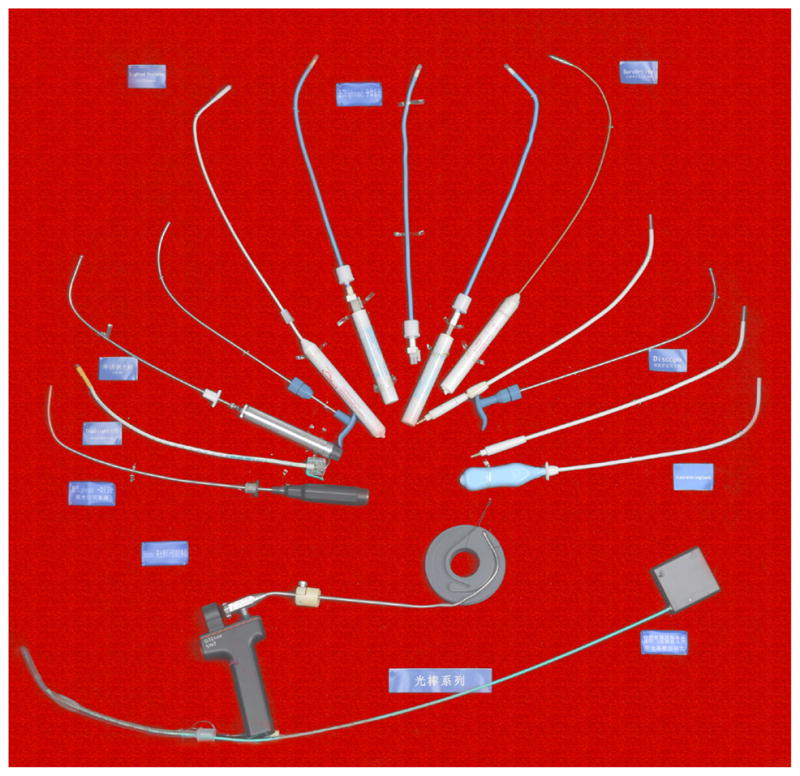
Optical stylets.